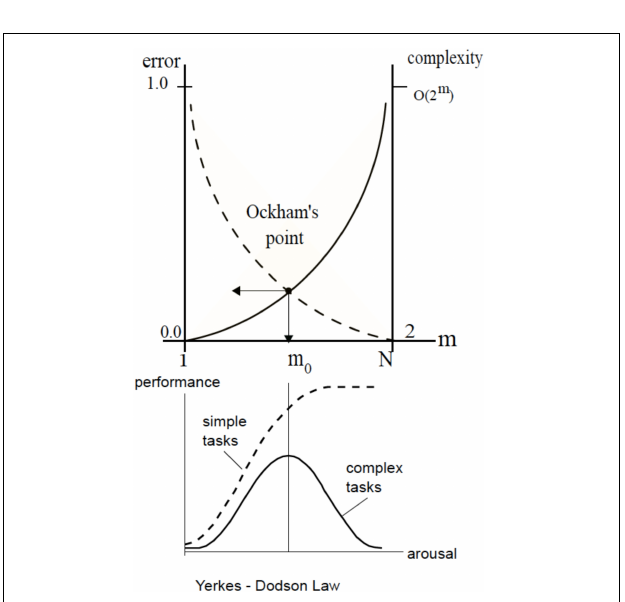
FIGURE 10 | The shape of the energy landscape is a function of interplay between arousal and value distribution across the packets (reflecting value distribution in the corresponding objects). Heightened arousal lowers energy barriers across the landscape enabling coordination of distant packets, as might be necessary for unfamiliar and complex (creative) tasks, while decreasing arousal elevates the barriers thus restricting coordination to proximal packets (which might suffice for simple and familiar